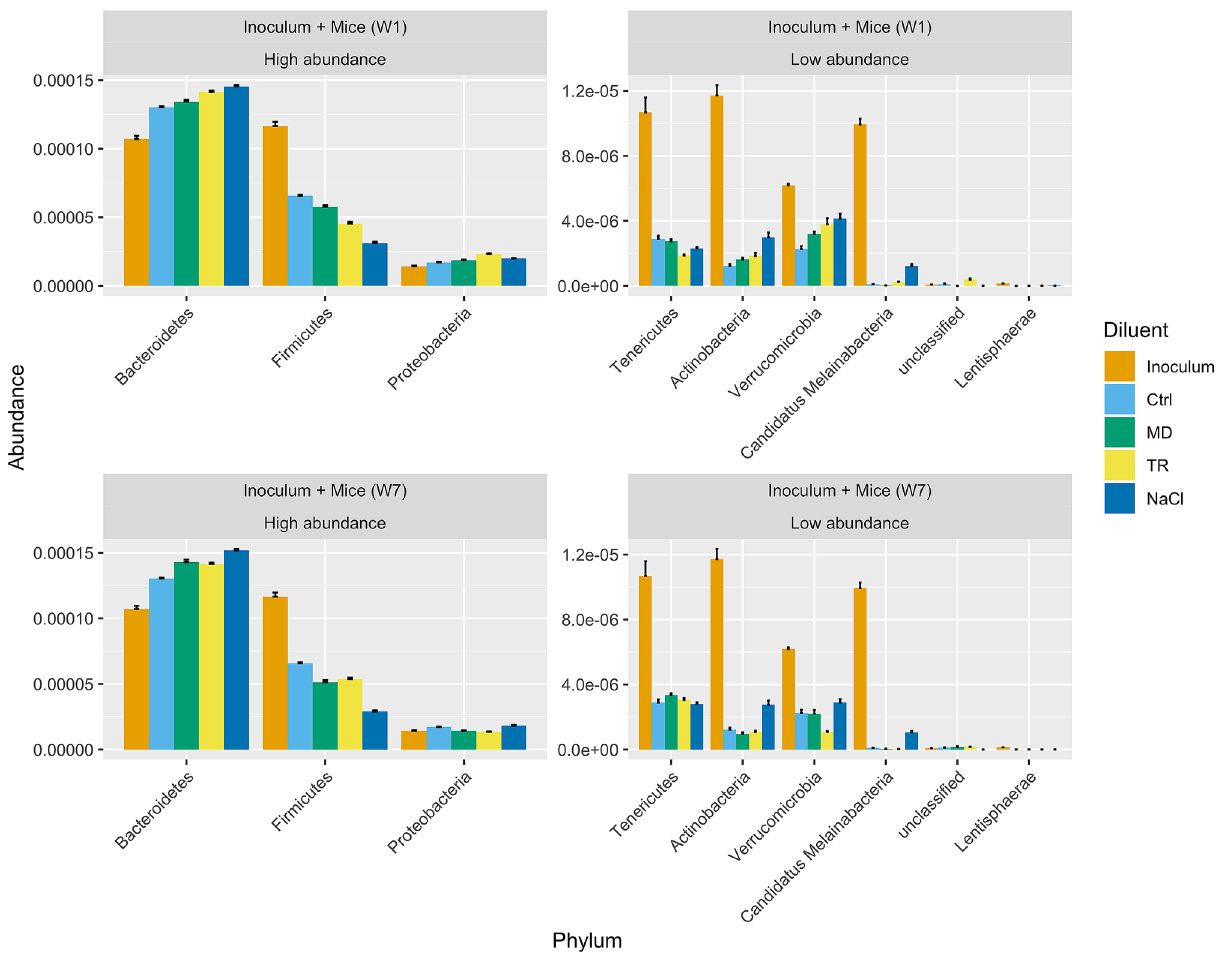
Figure 4. Total abundances of MSP at the phylum level in the inocula and the transplanted mice. Ctrl: mice transplanted with the fresh inoculum in NaCl; MD, TR, NaCl: mice transplanted with the same stool specimen that has been stored at − 80 °C for one week (top panels) or seven weeks (lower panels) in either MD, or TR, or NaCl. Values are means with standard errors in mice feces collected at day 2, 4 and 15, or in NaCl, MD and TR